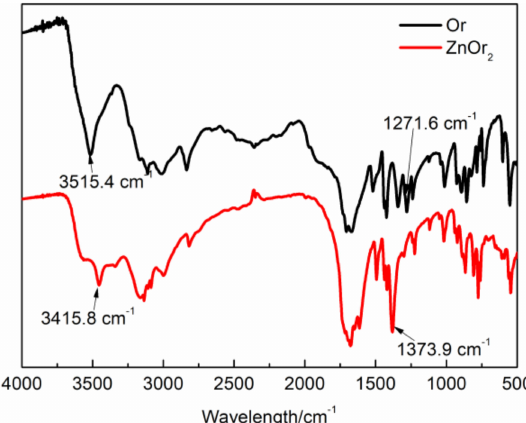
Figure 2. The Fourier transform infrared (FTIR) spectra of Or and ZnOr 2 .